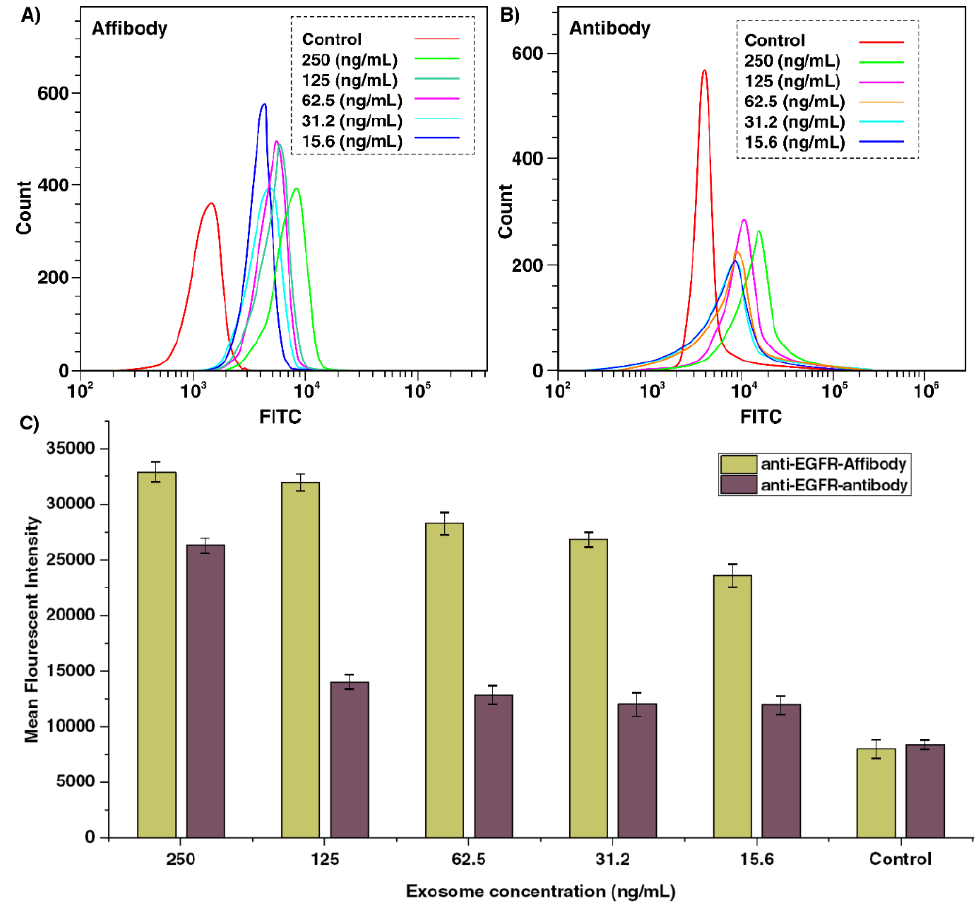
Figure 5. The flow cytometry histogram overlay for 200, 100, 50, 25, and 12 exosomes (~250 ng · mL − 1 , 125 ng · mL − 1 , 62.5 ng · mL − 1 , 31.2 ng · mL − 1 , and 15.6 ng · mL − 1 total exosome protein) captured on the surface of ( A ) AffiBeads probe and ( B ) anti-EGFR antibody-coated microbeads measured with flow cytometry. ( C ) The MFI for the 12, 25, 50, 100 and 200 ratios of exosomes to the AffiBeads probe and anti-EGFR-coated microbeads. The AffiBeads probe, similar to antibody-coated microbeads, shows a linear response in fluorescent signal intensity and 15.6 ng/mL (6.3 × 10 5 exosome ~15.6 ng · mL − 1 (12 exosomes per microbeads)) could be detected using this